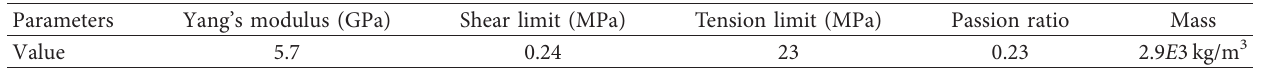
Figure 2: Numerical simulation model of rock cutting with the diamond sawblade. (a) Vertical cutting rock model with the diamond sawblade., (b) Rock cutting model with fixed depth of the diamond Table 1: Key performance parameters of rock.